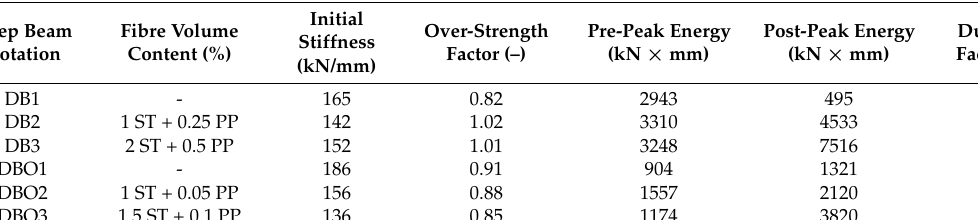
Table 5. Deep beam parameters.